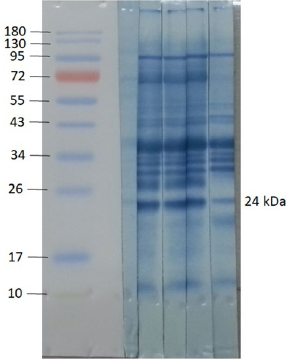
Figure 4. Western blot analyses of aL3Gs with the molecular weight (MW) markers indicated in kDa on the left. Each membrane strip (1–5) is incubated with sera from 5 different individuals diagnosed with gnathostomiasis. The 24-kDa gel regions were excised, and protein components explored against transcriptomic database